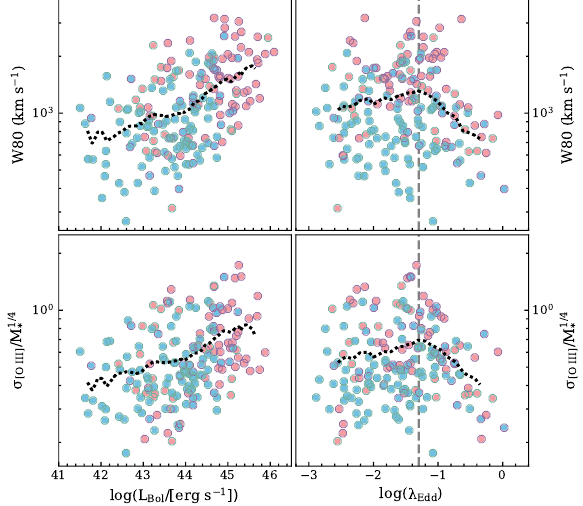
Figure 14. The distribution of W80 ( top ) and normalized [O III ] velocity dispersion ( bottom ) as a function of bolometric luminosity ( left ) and Eddington ratio ( right ). The black dotted lines illustrate the running mean in each panel. The grey dashed lines in the right panels indicate log ( λ Edd ) = − 1.3. The colors are identical to that in Figures 7 and